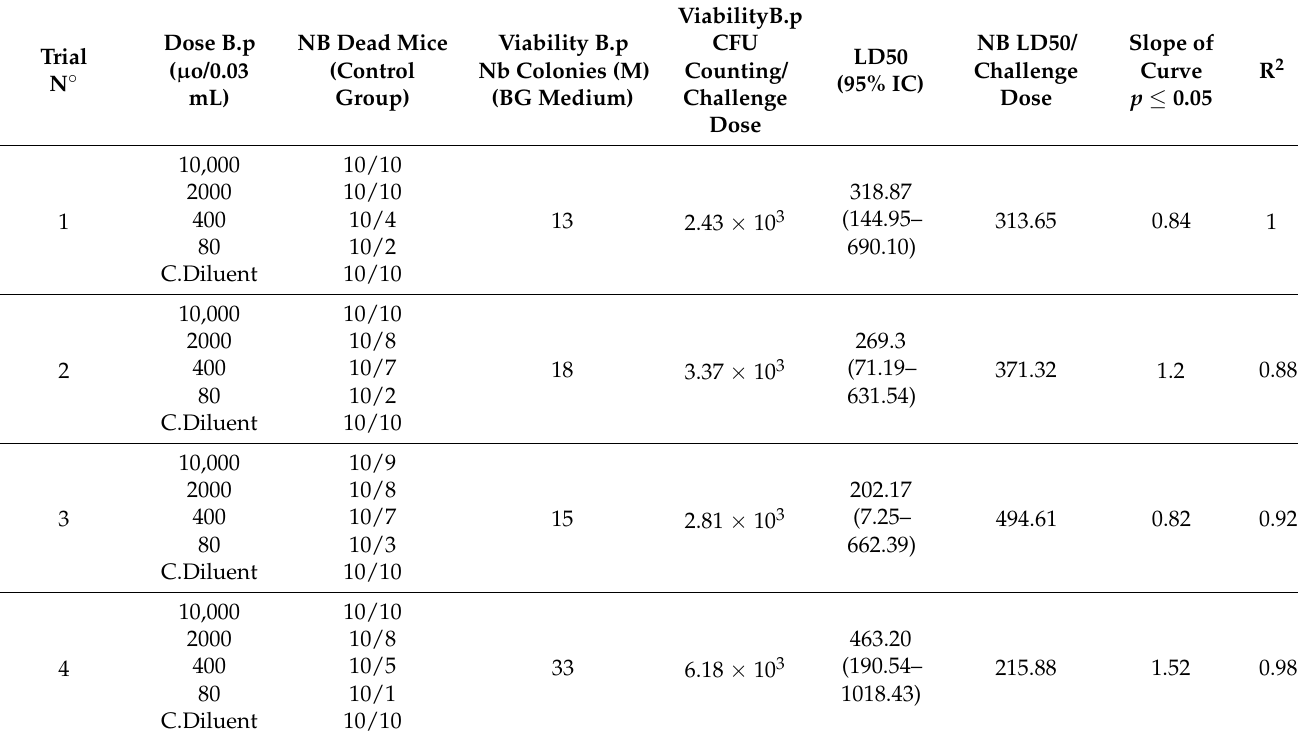
Table 1. Estimation of the lethal LD50 and number of LD50 of B. pertussis strain 18–323 used in the challenge test of the pertussis component of the five DTP vaccine trials (vaccine test 1, 2, 3, 4, 5) in mice of control group/and Control of the viability of B. pertussis strain